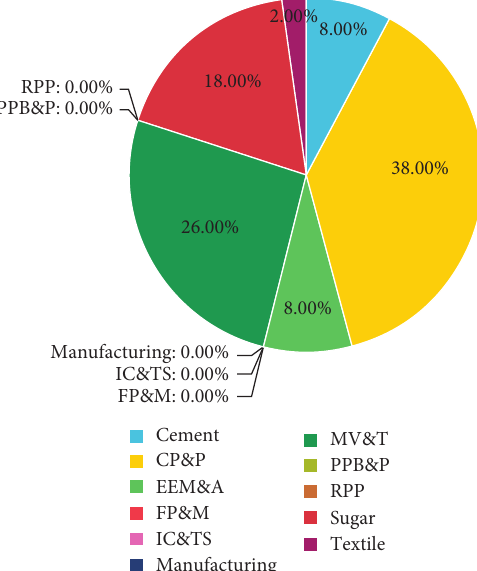
Figure 4: Decomposition of financial expertise (master in A&F) in equity market.